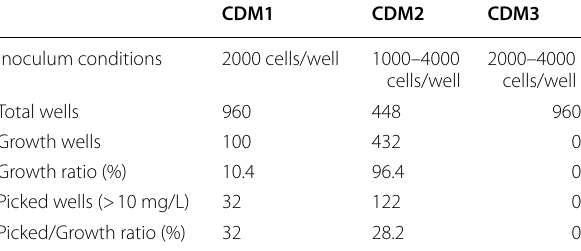
Table 4 Summary of mini-pool screening